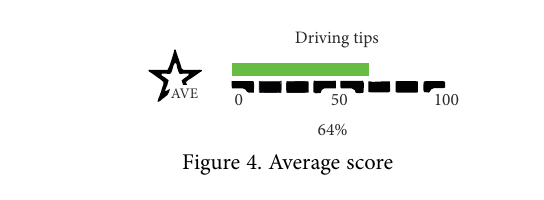
Figure 3. Average driving results display according to the SDS